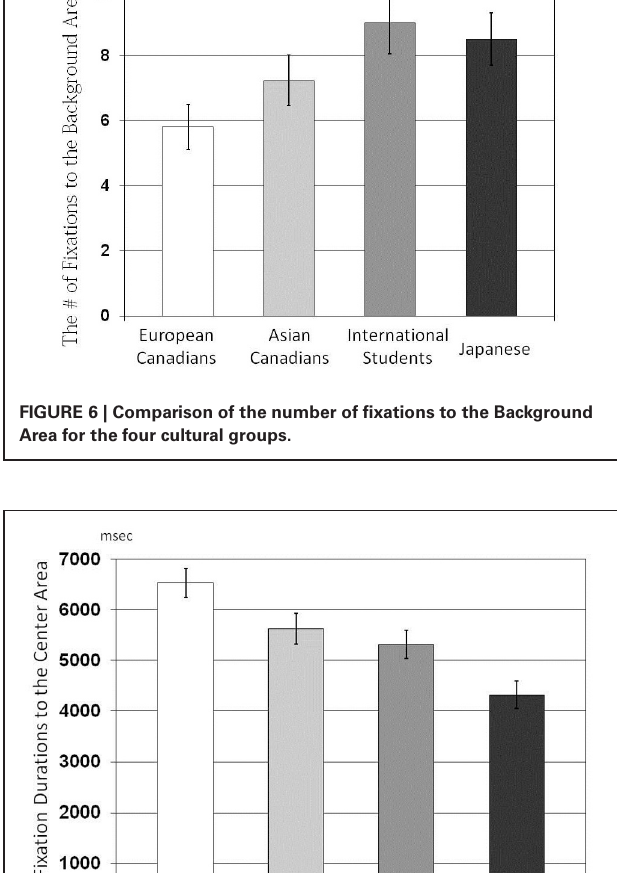
FIGURE 5 | Comparison of the number of fixations to the Center Area for the four cultural groups.